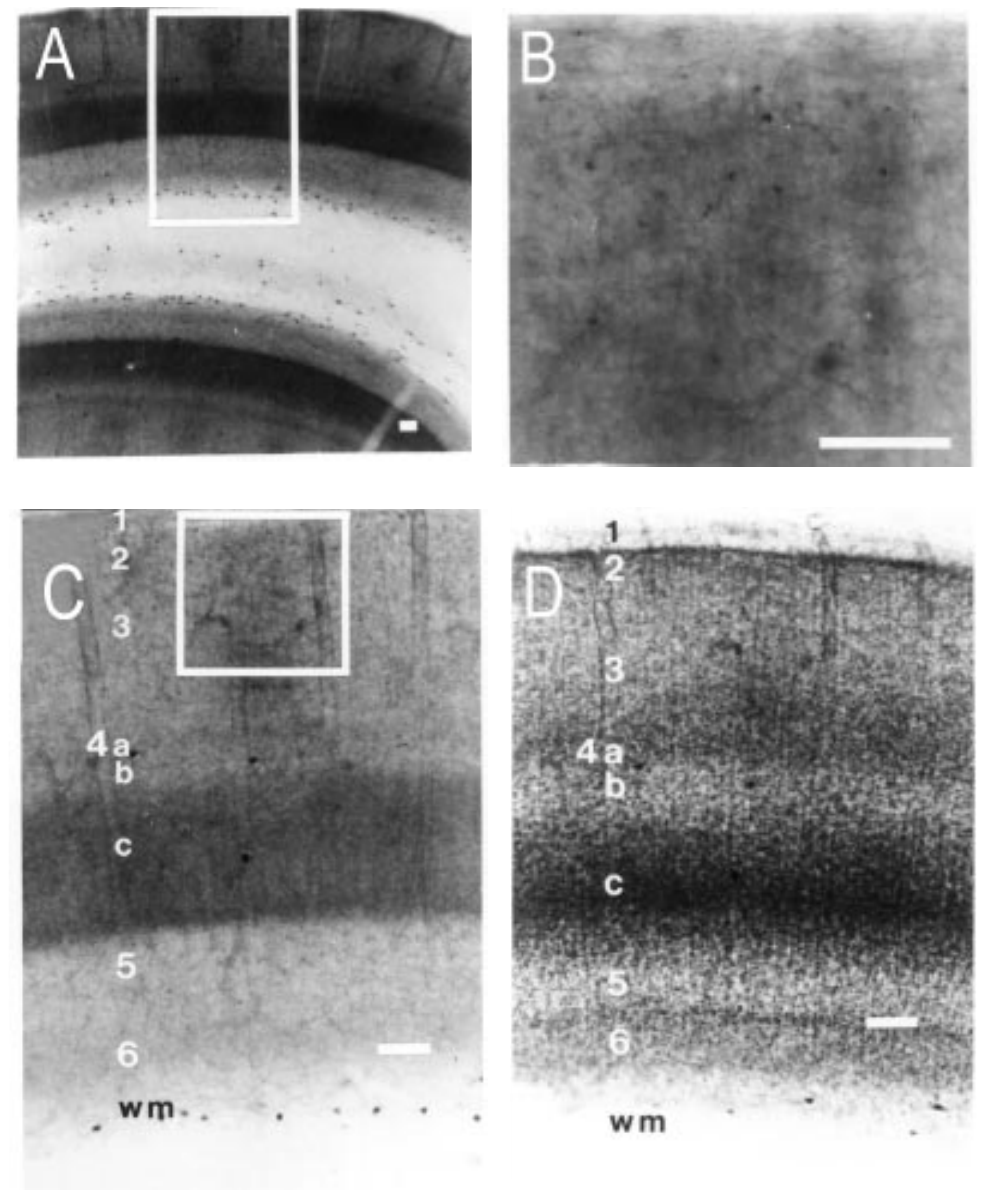
Figure 1 - Parasagittal section through area 17 of a squirrel monkey processed for NADPH-diaphorase activity and then stained with cresyl violet. A , Low magnification before cresyl violet stain. NADPH-diaphorase-positive neuropil provides a clear laminar pattern and blobs in supragranular layers. Some NADPH-diaphorase-positive neurons can be seen as dark dots in the white matter (wm). The region enclosed in the box is magnified first in C and then in B. B , Higher magnification of the supragranular neuropil activity enclosed in the box shown in C. The cell bodies of some weakly stained NADPH-diaphorase-positive cells can be seen. C , NADPH-diaphorase cortical lamination is coherent with the pattern obtained after cresyl violet staining (shown in D). D , Same section as in C after cresyl violet staining. Scale bar = 100